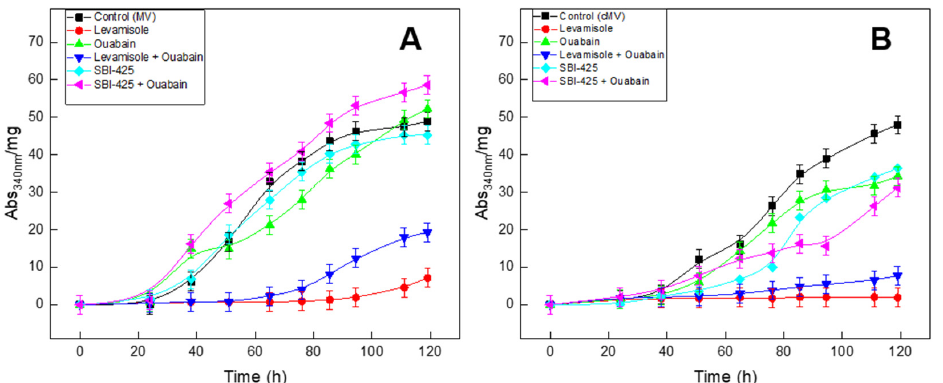
-- SBI-425 inhibited a maximum of 33.4% of the total activity of the cTNAP, removed from the MV. This value is in agreement with the results of the experiments carried out previously with ATP at 3.0 mM as a substrate (Table 1) but less than expected based on the inhibition properties of human and mouse TNAP. The active site pocket of chicken